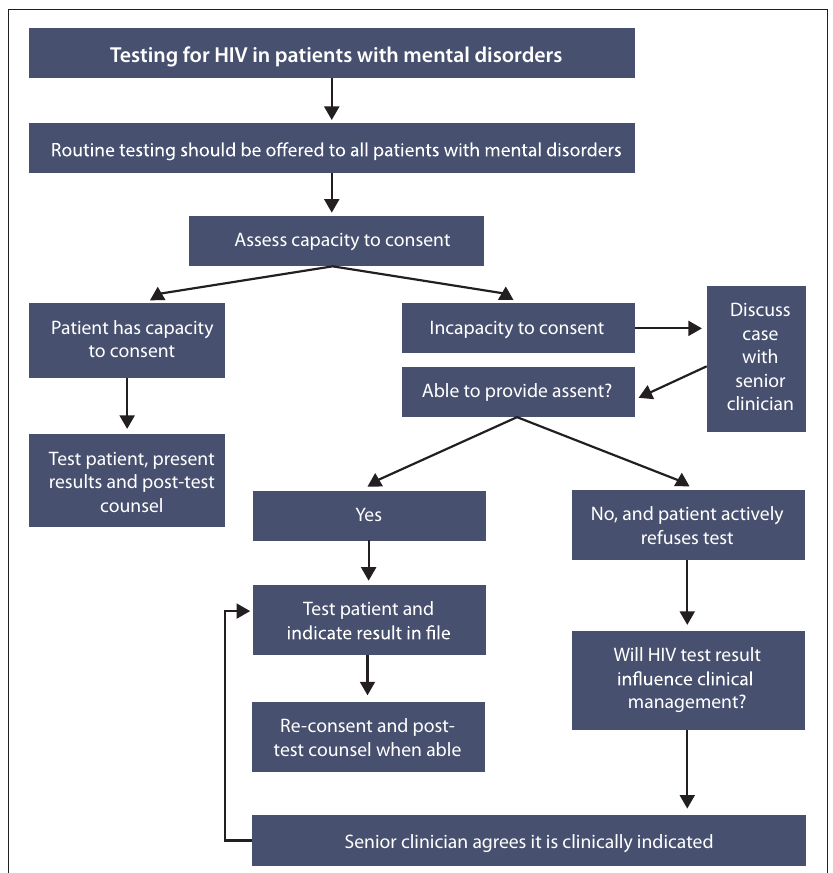
Fig. 1. Testing for HIV in patients with mental disorders.